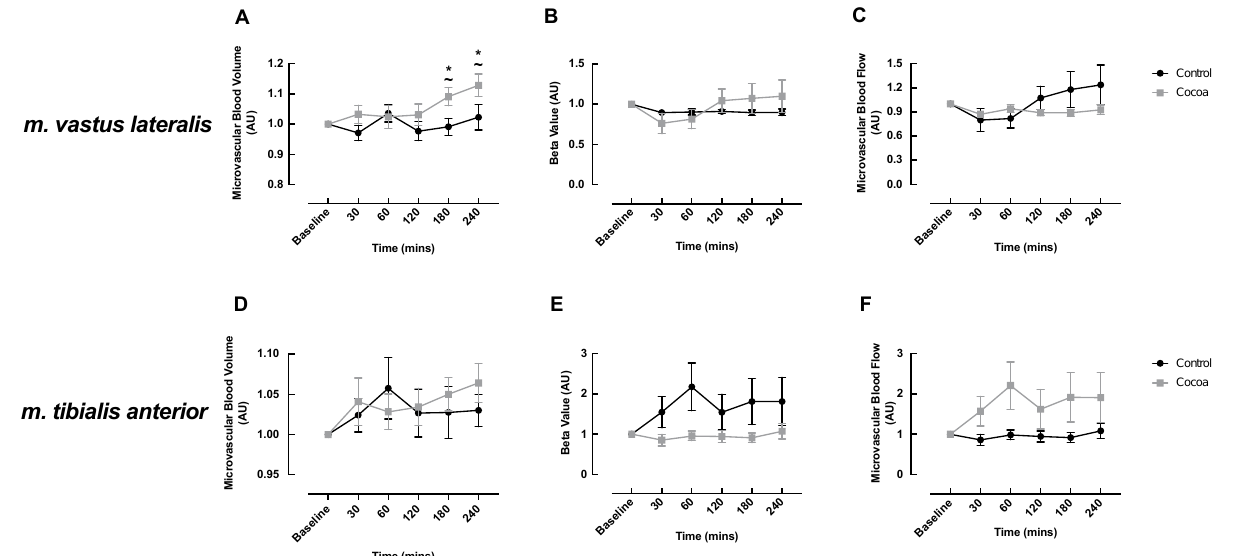
Figure 3. Cocoa enhanced oral nutritional supplement feeding-induced changes in microvascular blood volume ( A ) but not microvascular flow velocity ( B ) or microvascular blood flow ( C ) in the m. vastus lateralis and did not influence microvascular perfusion of the m. tibialis anterior ( D – F ) of healthy older adults. ~ denotes a significant difference between conditions ( p < 0.05); * denotes significant within condition difference from cocoa baseline ( p < 0.05).